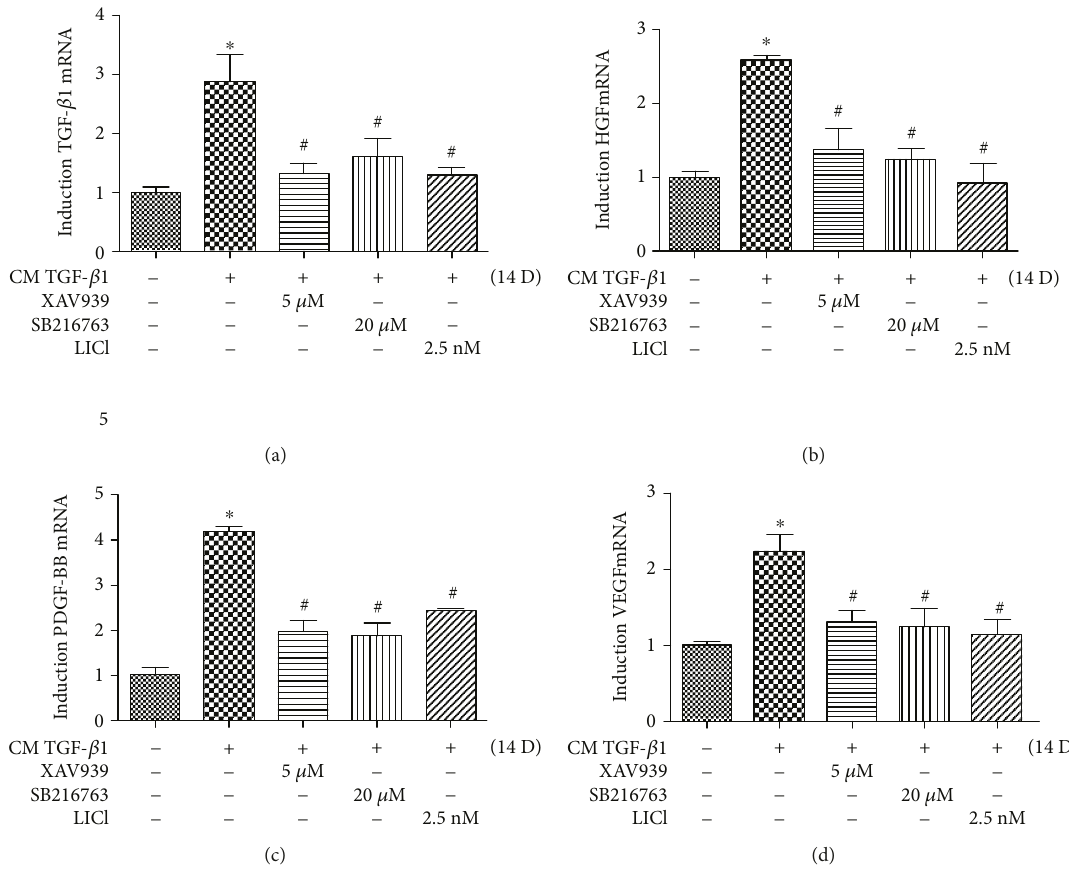
Figure 6: Wnt/GSK3 β / β -catenin is involved in the process of SMC di ff erentiation from the DPSC clone A32 through regulation of growth factors.The A32 clone was induced following the SMC induction protocol with or without the Wnt/ β -catenin-speci fi c inhibitor, XAV939, as well as the GSK3 inhibitors, SB216763 and LiCl, for 14d. The mRNA expression of TGF- β 1 (a), HGF (b), PDGF-BB (c), and VEGF (d) were analysed with qPCR. Statistical analysis was performed by using one-way ANOVA. Data are shown as means ± SEM . ∗ P < 0 05 when compared with the control